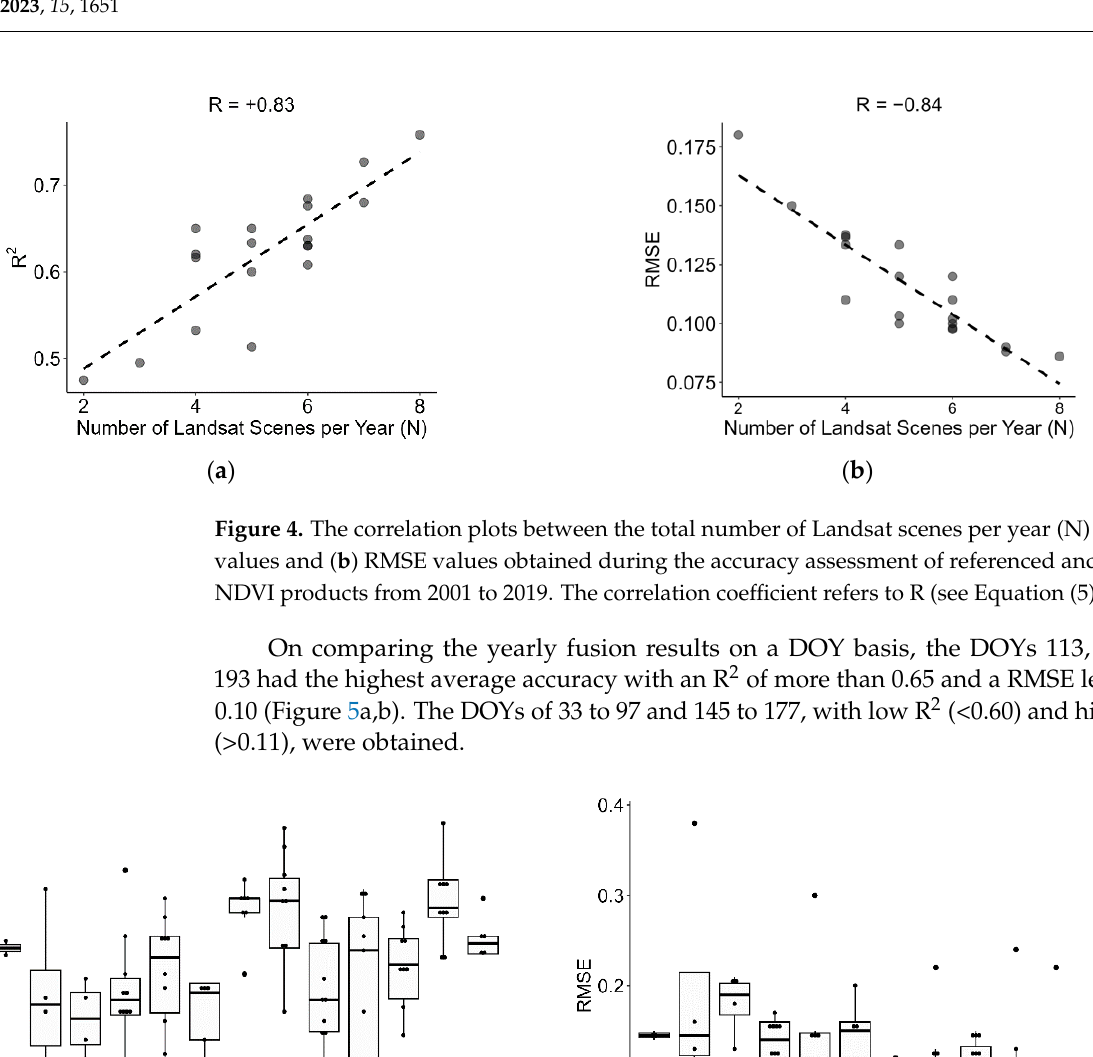
Figure 5. The day of the year (DOY)-based comparison of correlation coefficients between ( a ) R 2 values and ( b ) RMSE values obtained during the accuracy assessment of referenced and synthetic NDVI products from 2001 to 2019. The correlation coefficient refers to R (see Equation (5)).